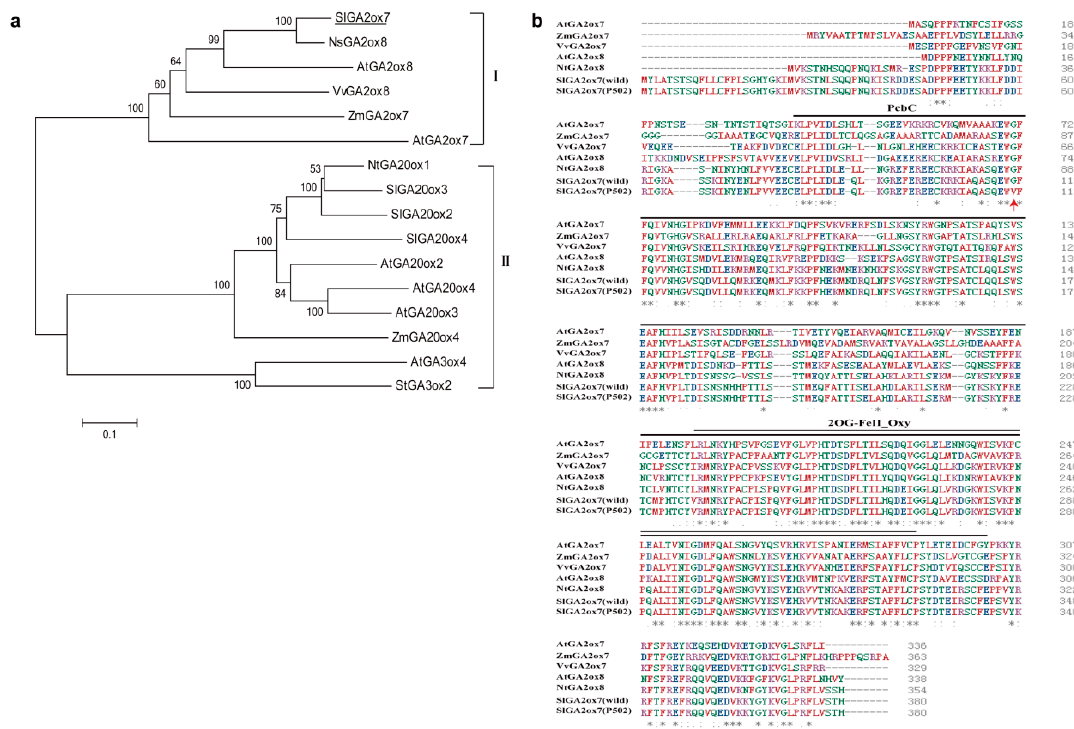
Figure 5. Phylogenetic analysis and sequence alignment of SlGA2ox7 with various species. ( a ) Phylogenetic analysis of SlGA2ox7. The phylogenetic tree was generated using the neighbor-joining method built in MEGA6.0, and the inferred phylogeny was tested by bootstrap analysis with 1000 replicate datasets. Numbers shown at the tree forks indicate the frequency of occurrence among all bootstrap iterations performed. ( b ) Alignment of the SlGA2ox7 sequences. The proteins were aligned with the ClustalW program. The bold black line and the thin black line indicate the PcbC domain (81–343) and 2OG-FeII_Oxy domain (237–332), respectively. The red arrow represents the amino acid at position 112 of SlGA2ox7.